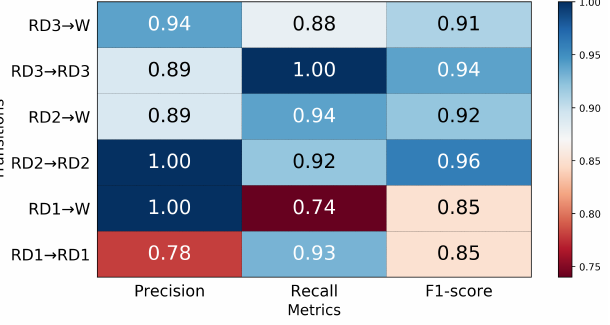
Figure 12. The precision, recall, and F1-score for transitions from ramp descent 250ms prior to